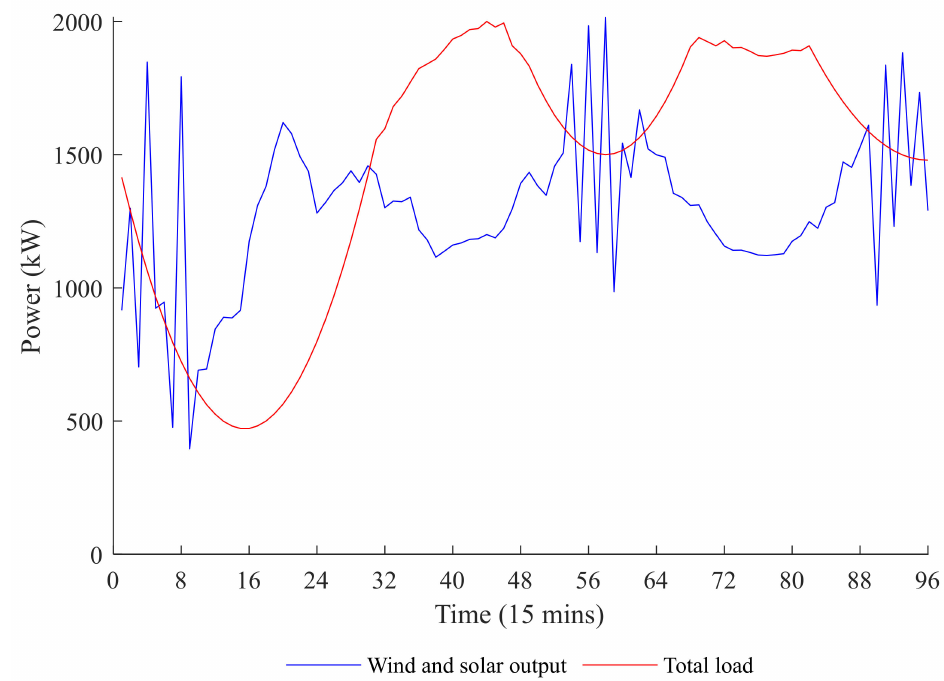
Figure 4. The prediction results of the wind and solar output and the total load power.